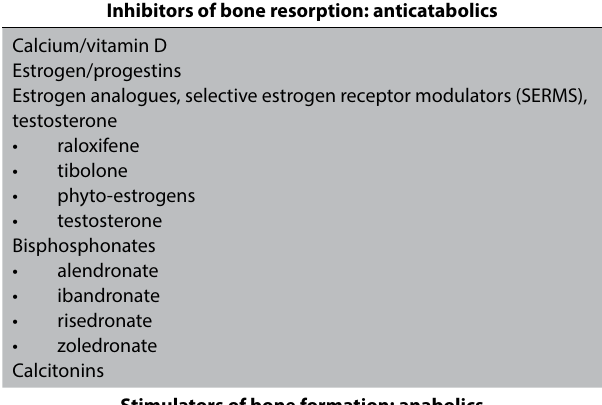
Table IX: Drugs currently used to treat osteoporosis Inhibitors of bone resorption: anticatabolics Calcium/vitamin D Estrogen/progestins